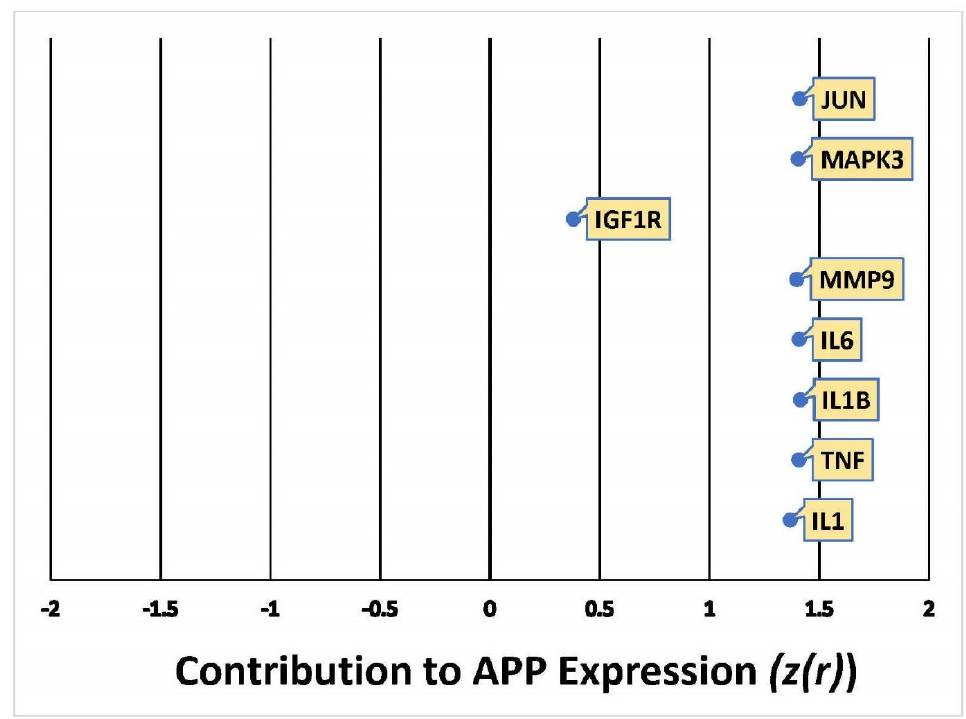
Figure 3. Quantitative illustration of the change in APP expression in response to METH exposure. The overall change in APP expression in response to METH exposure by the 8 intermediate mole- cules was measured by the individual involvement, Z-score (z(r)), of each